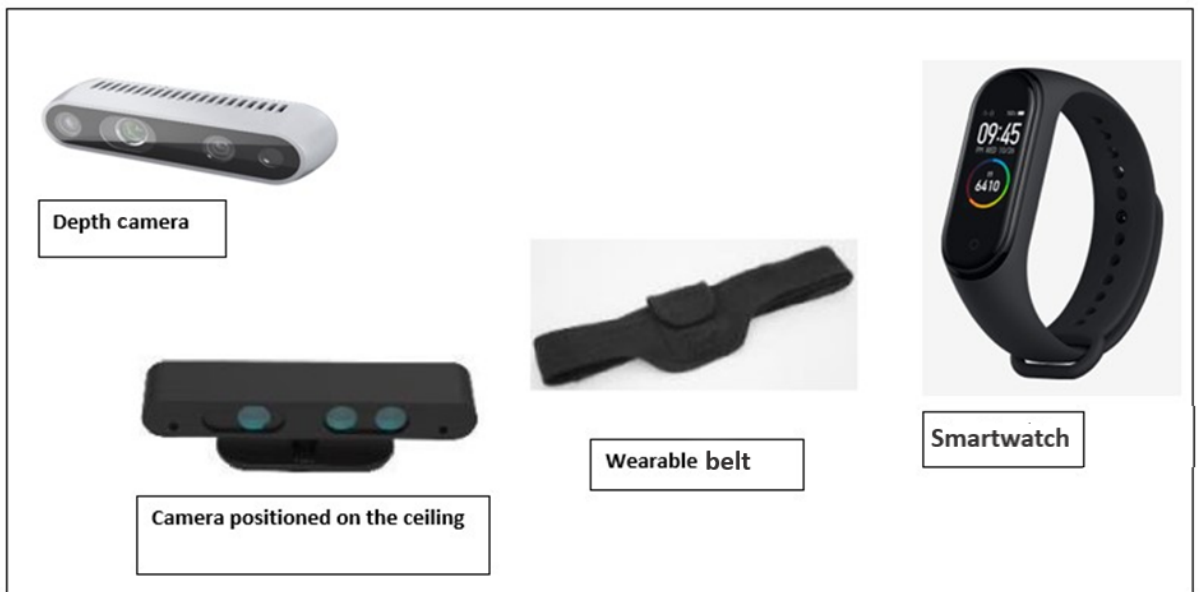
Figure 3. Example images of PROCare4Life tools and sensors viewed in interviews and workshops. PROCare4Life: Personalized Integrated Care Promoting Quality of Life for Older